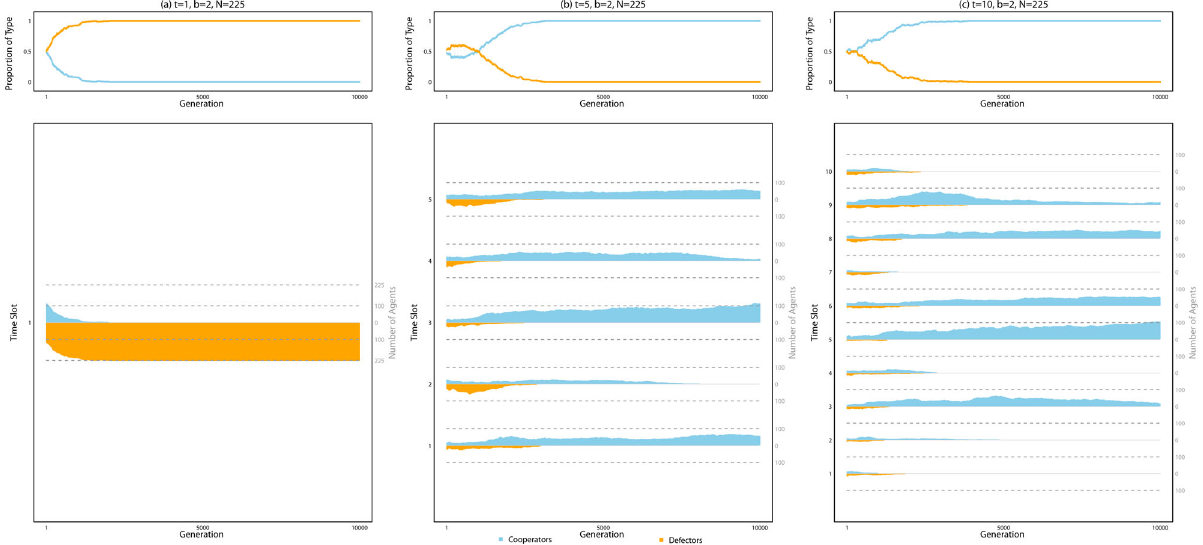
Fig. 2 Selection for cooperation in the presence of multiple time slots in an example run of the simulation. Panels display data from the same example simulation runs displayed in Fig. 1, with parameter settings appearing above the uppermost panel in each column. The upper row of panels displays the respective proportions of cooperators (light blue) and defectors (orange) in the population at each of the 10000 generations of the simulation run. The lower row of panels shows the number of cooperators and defectors in each time slot across generations, with time slots labeled on the left vertical axis and the right vertical axis measuring the number of cooperators and defectors at each time slot. Note that the vertical distance above 0 on the vertical axis measures the number of cooperators and the vertical distance below 0 (i.e., absolute value) measures the number of defectors. When t = 5 (middle panels) or t = 10 (right panels), selection favors cooperation and prosocial behavior evolves at multiple time fi xation at a slower rate, thus leading to a greater frequency of runs fi tness proportional selection and asynchronous updating yields in which cooperation cannot spread through the entire population qualitatively similar results (see Fig. 4). Adding time slots to the by G = 10000, even though a plethora of agents adopt it. model and allowing selection to operate on organisms ’ choices of which time slot to implement behavior increases the frequency of simulation runs resulting in the fi xation of cooperators. When t = 1, 37.2% of all runs end with the fi xation of cooperators; that types and time of implementation in a small-world network with percent increases to 56.7% when t = 2, grows to 76.9% when